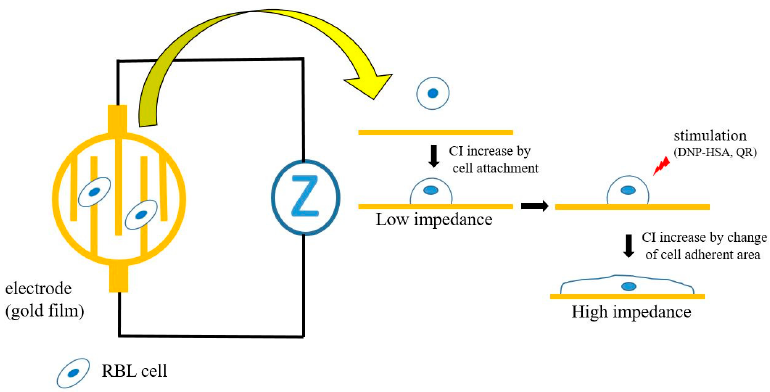
Figure 1. Schematic of the impedance system for living cells. The impedance sensor detects the attachment and morphological change of cells on electrodes.